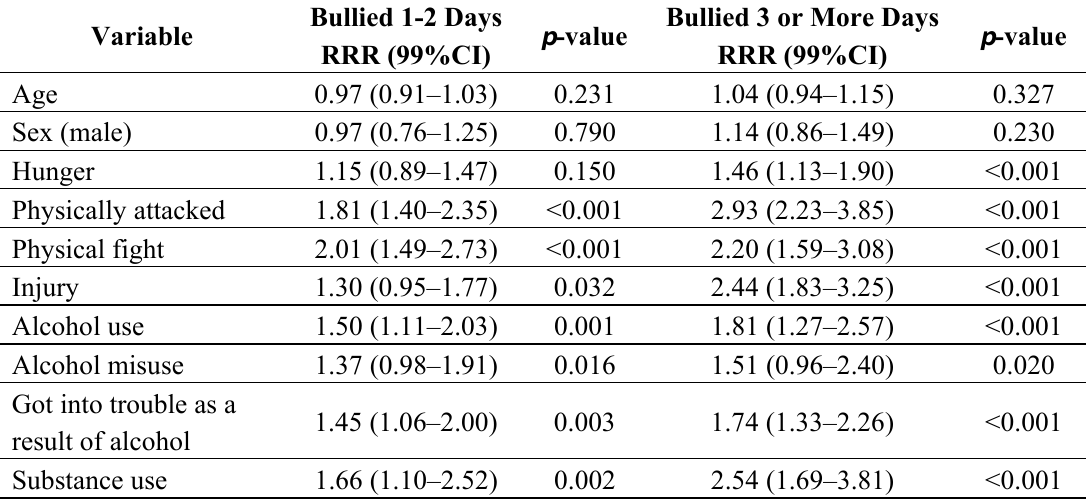
Table 4. Multinomial logistic regression analyses of selected variables according to bullying category among adolescents in